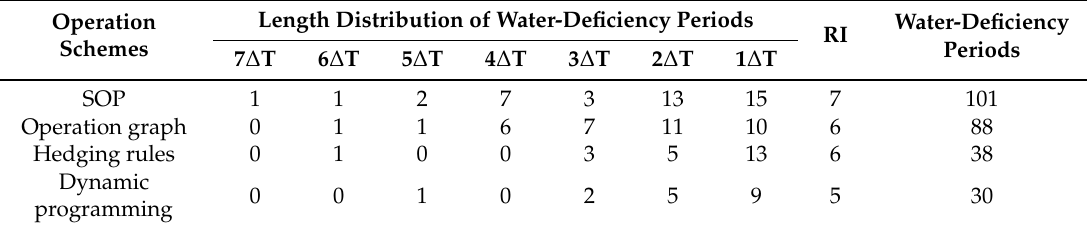
Table 3. Water supply damage recovery ability of different